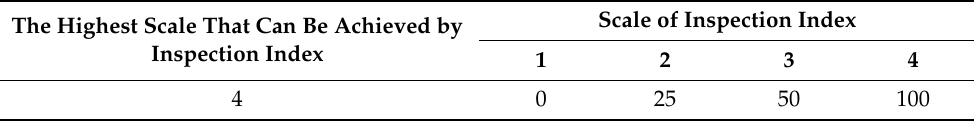
Table 7. Deduct point of inspection index.